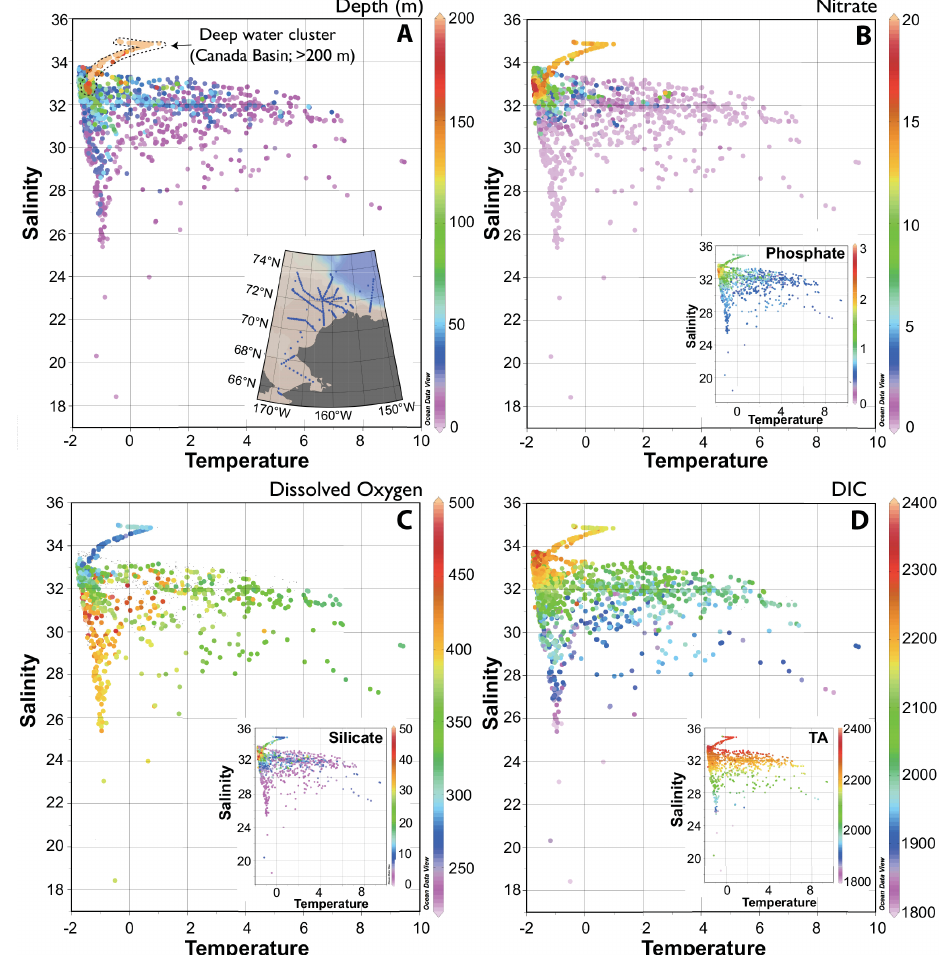
Figure 2. Water column hydrography and marine biogeochemistry of the 2010 and 2011 ICESCAPE cruises. (a) Temperature ( ◦ C) versus salinity with range of colour denoting depth (in metres), and locations of 2010 and 2011 ICESCAPE hydrocast-CTD stations shown in the inset. The depth of samples collected below 200m is not differentiated colourwise, and represents water depths to > 4000m. With this in mind, the approximate range of deep water (Canada Basin) hydrographic properties are shown within the dashed line. (b) Temperature ( ◦ C) versus salinity with range of colour denoting nitrate concentration (µmol kg − 1 ) with phosphate (µmolkg − 1 ) shown in the inset. (c) Temperature ( ◦ C) versus salinity with range of colour denoting dissolved oxygen concentration (µmolkg − 1 ) with silicate (µmolkg − 1 ) shown in the inset. (d) Temperature ( ◦ C) versus salinity with range of colour denoting dissolved inorganic carbon (DIC) concentration (µmolkg − 1 ) with total alkalinity (TA;µmolkg − 1 ) shown in the